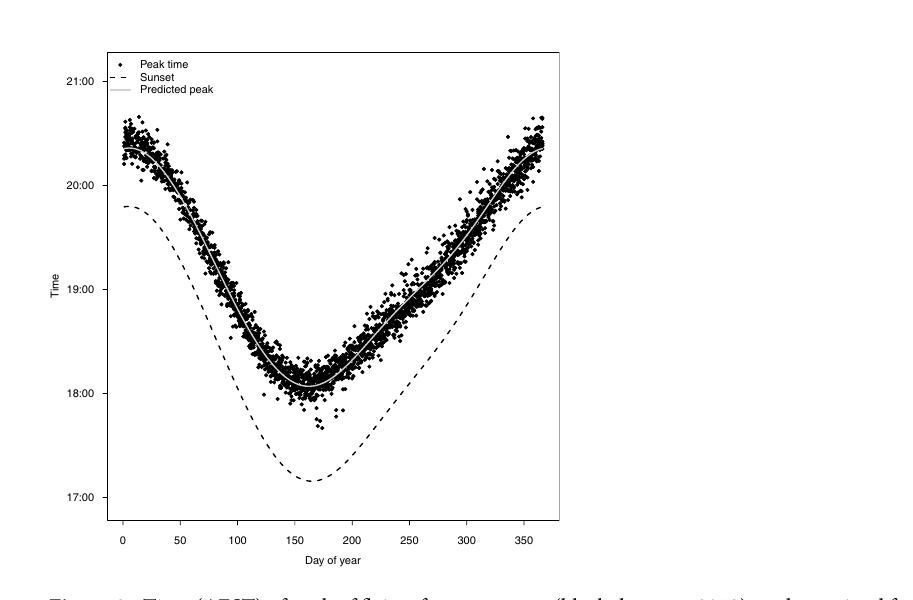
Figure 3. Time (AEST) of peak of flying-fox emergence (black dots, n = 2950), as determined form radar data, versus time of year at the Yarra Bend roost. Local sunset time is marked as a black dashed line and the predicted peak emergence time from a sine/cosine model is shown as a grey